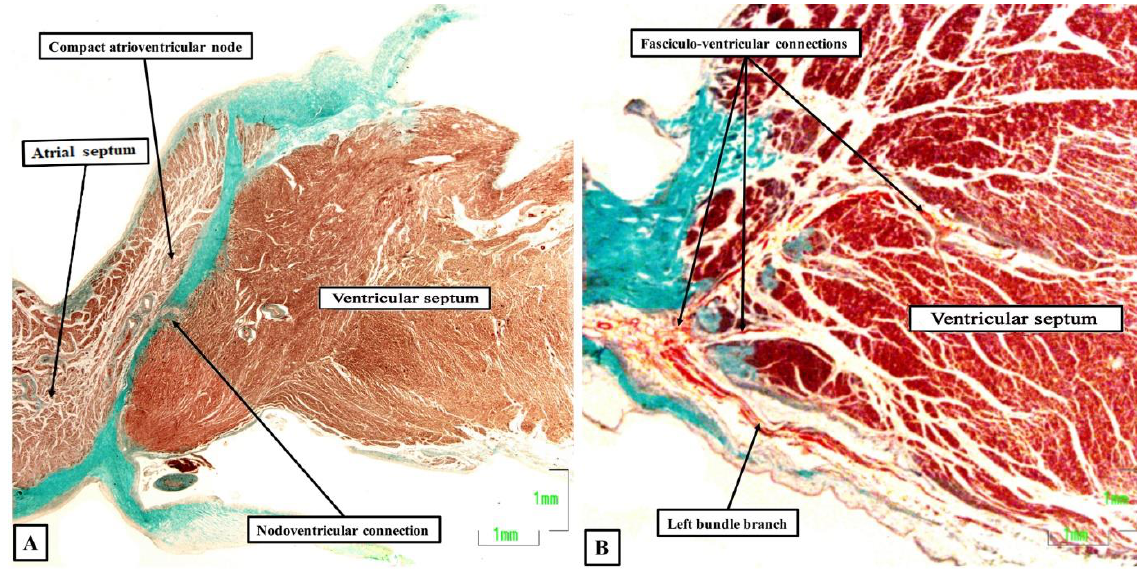
Figure 3 . Nodo-ventricular and fasciculo-ventricular pathways: The sections are again stained using the trichrome technique. ( A ) shows a nodo-ventricular connection in an infant human heart, while ( B ) shows multiple fasciculo-ventricular connections in an adult human heart.